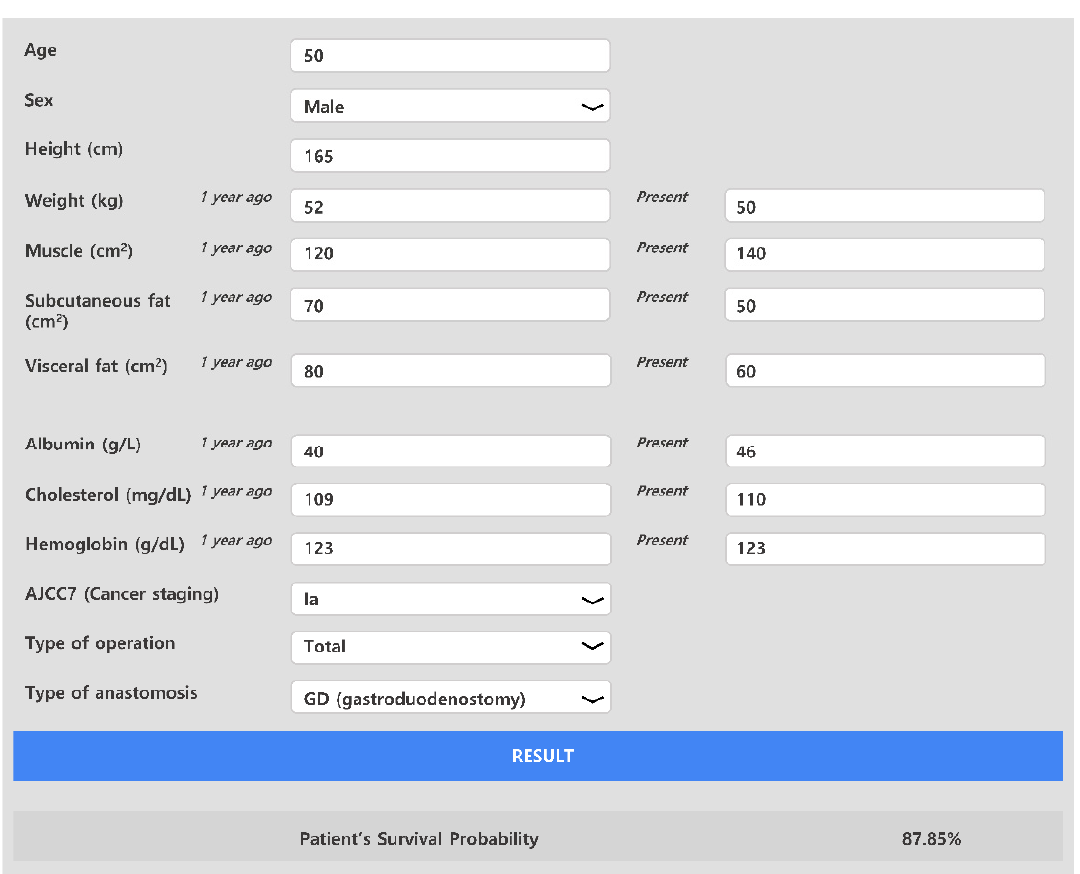
Figure 6. Deployed web application: user inputs both preoperative and postoperative values for standardization of the time-dependent continuous variables.